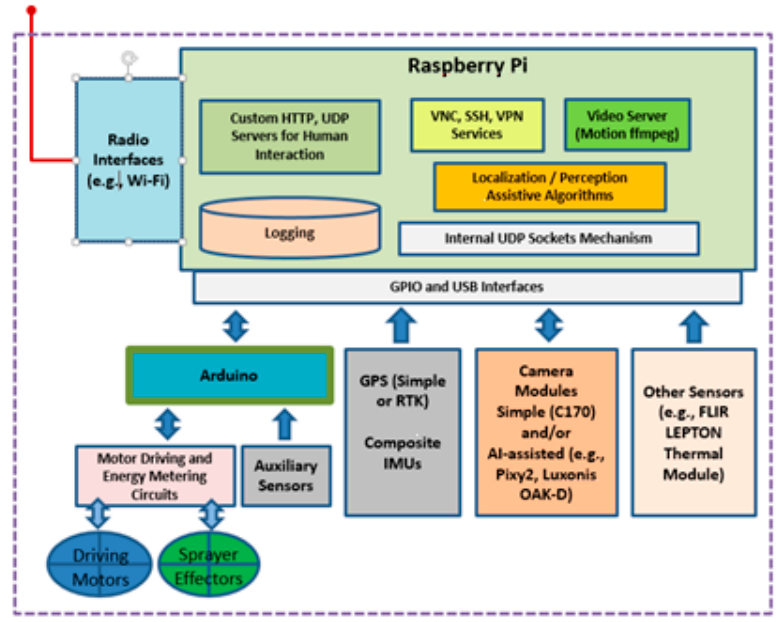
Figure 8. Interoperation of components in order to provide efficient and easy-to-understand func- tionality for the robots.